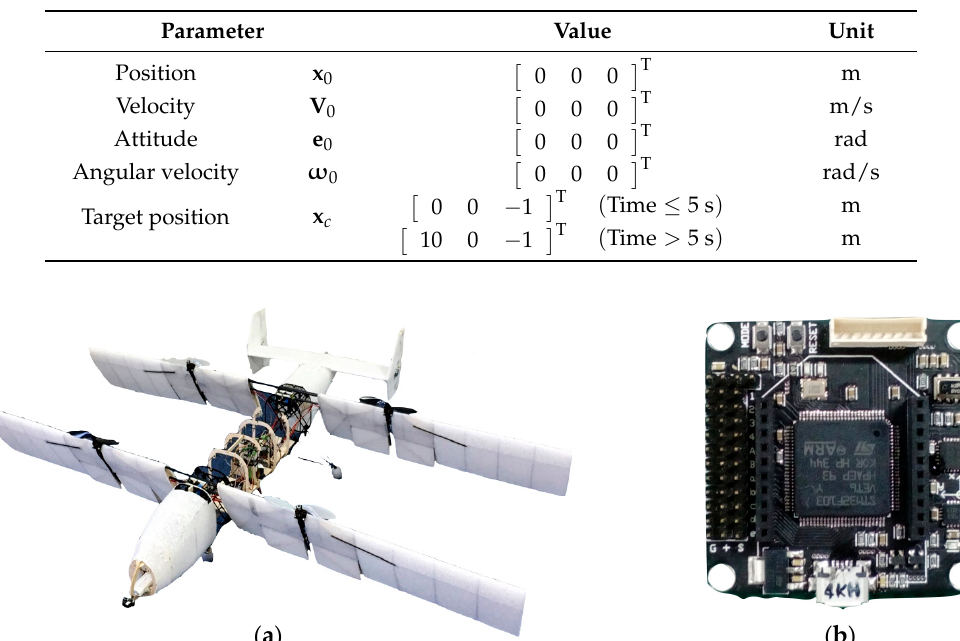
Figure 16. System diagram. ( a )